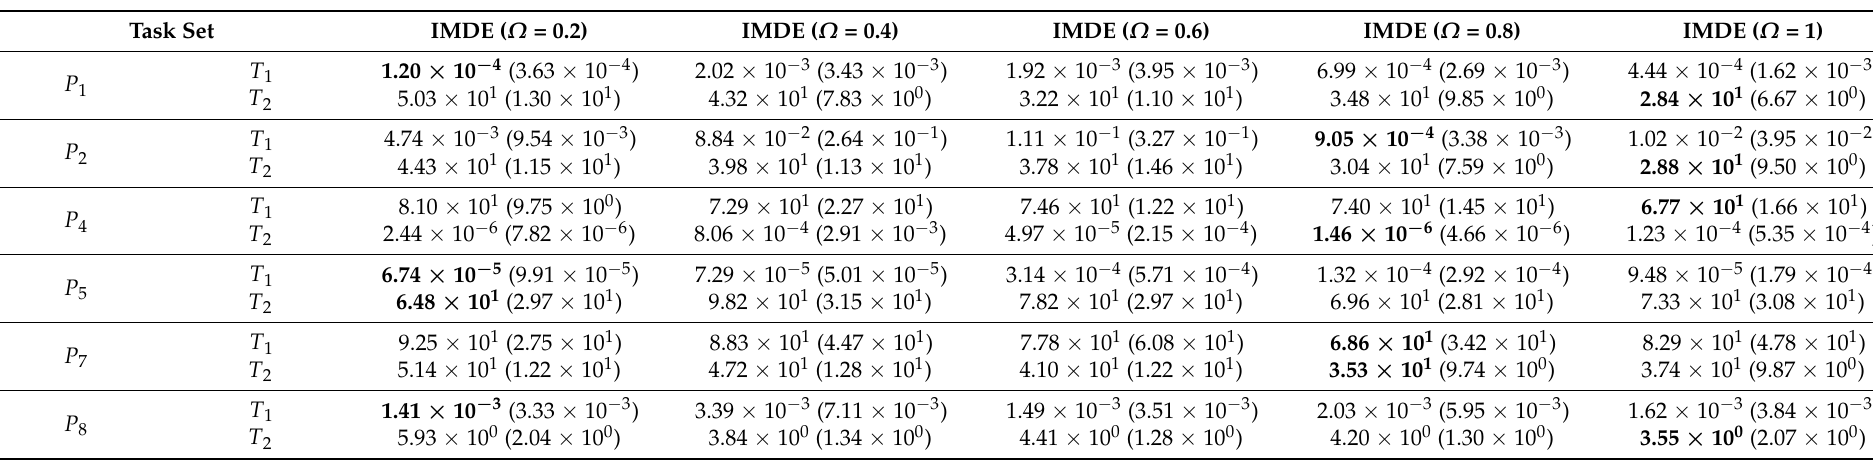
Table 2. The mean and standard deviation (in brackets) of the best achieved fitness values of IMDE with different communication rates.